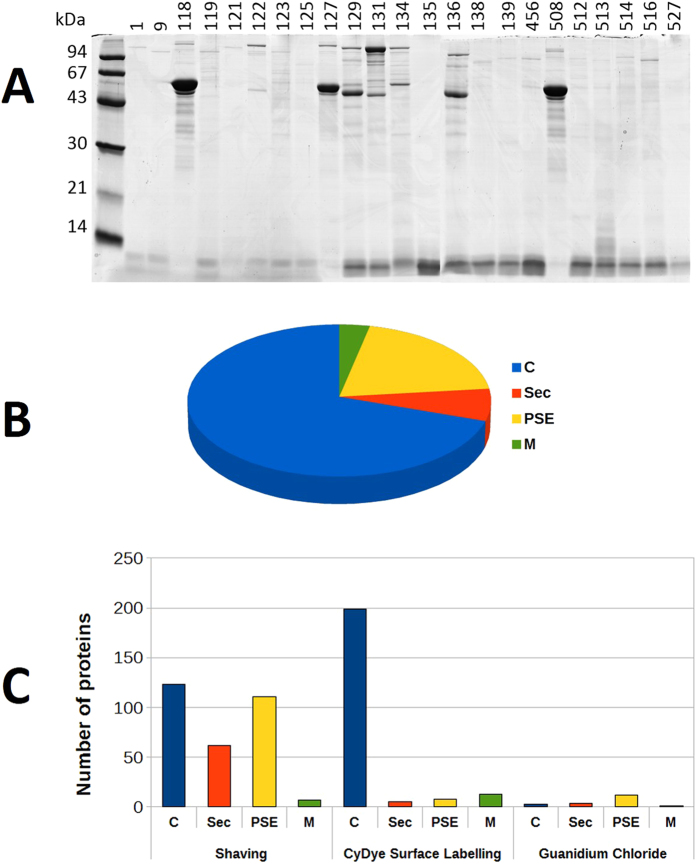
Diversity of Propionibacterium freudenreichii surface proteome and the distribution of identified surface proteins into in silico predicted localisations.(A) Guanidine hydrochloride-extracted proteins, analysed by SDS PAGE, evidenced variability among the Pf strains. (B,C). An inventory of the surface proteins of 12 Pf strains was further made by combining the three surface proteomic methods and produced a total of 509 proteomic identifications representing 174 different proteins. (B) Global distribution of in silico predicted localisations of the 174 different proteins identified. (C) Number and predicted localisations of the proteins identified using each analytical method: shaving, cyDye surface labelling and guanidine hydrochloride extraction (Le Maréchal et al.19). The localisations were predicted by SurfG + software, as described by Barinov et al.20 and the categories were as follows: (C) cytoplasmic protein, PSE: Protein surface exposed, M: membrane protein, SEC: secreted protein.